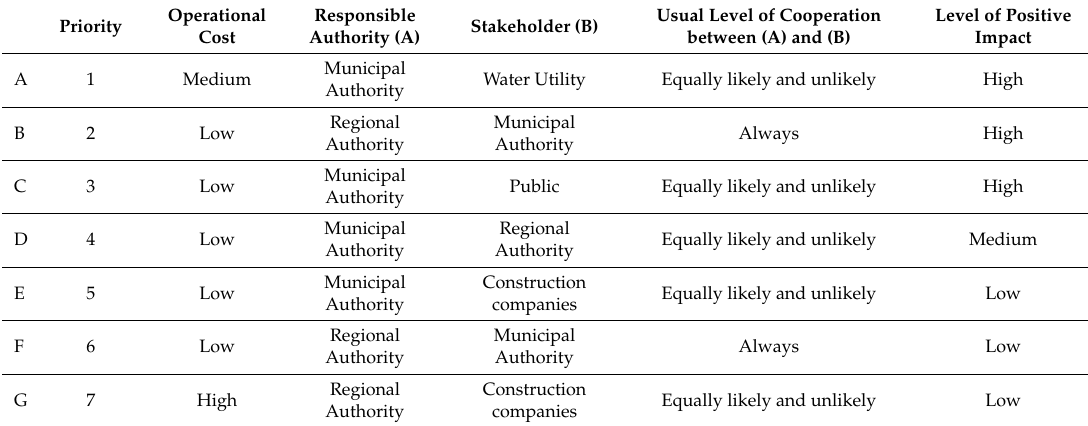
Table 3. Parameters defined related to flood preparedness actions under consideration.